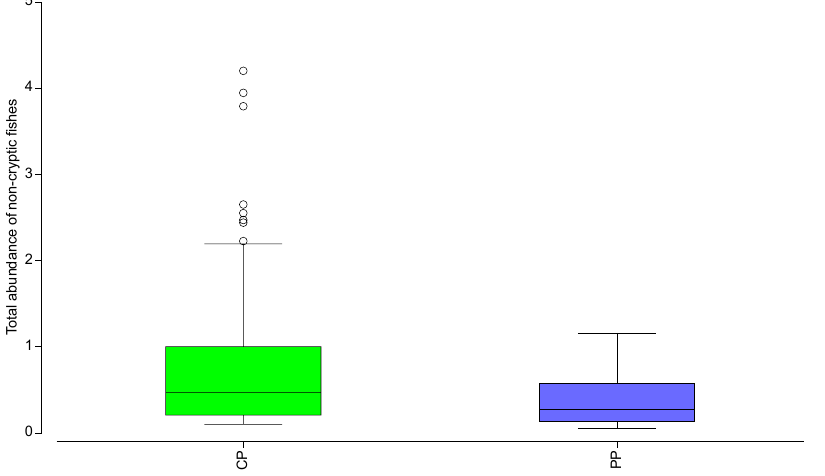
Figure 5. Non-cryptic fishes’ variation of total abundance (boxplot; nº/m 2 ) between partially pro- tected areas (PP; blue) and adjacent control areas (complementary protection areas; CP; green) of the northern marine PNSACV, significant at p = 0.001